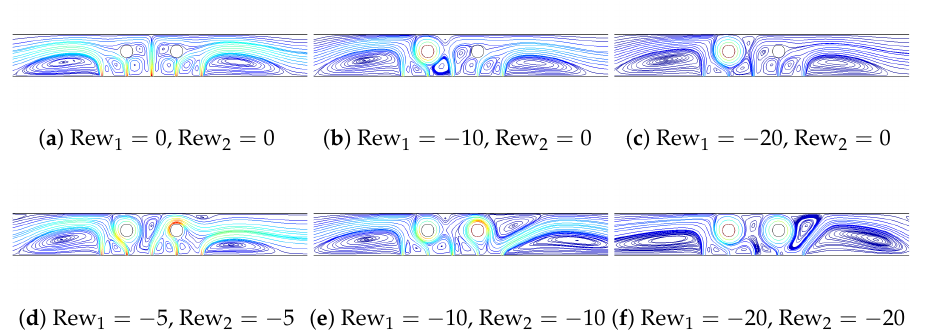
Figure 4. FP variations for different (Rew 1 ,Rew 2 ) combinations at (Rc = 0.1H, Sc = 6Rc, ∆ T = 10, SVF = 3%).